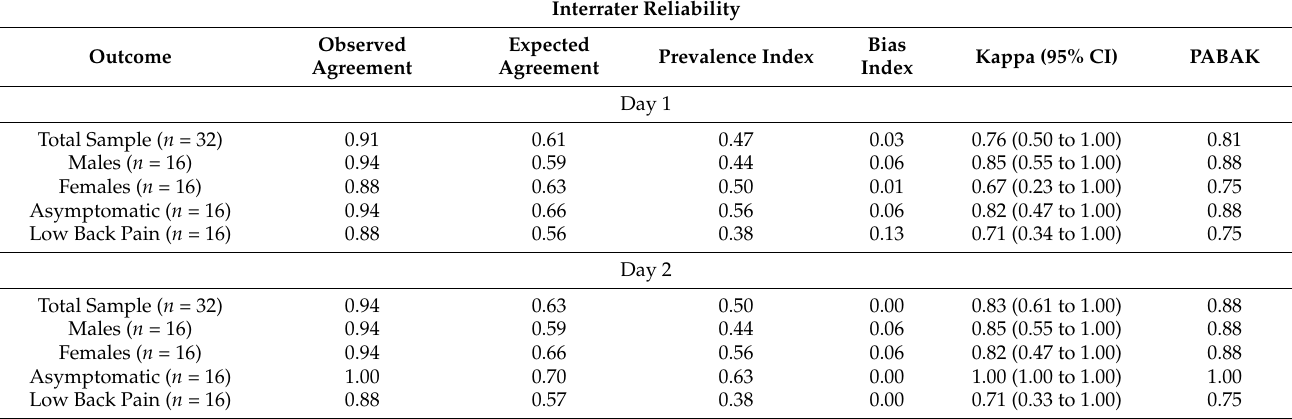
Table 3. Interrater and intrarater test-retest reliability of manual palpation during the abdominal drawing-in maneuver